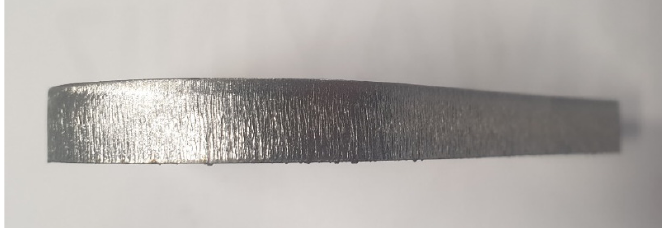
Figure A2. Edge surface quality of the cut 8 mm stainless steel workpiece.